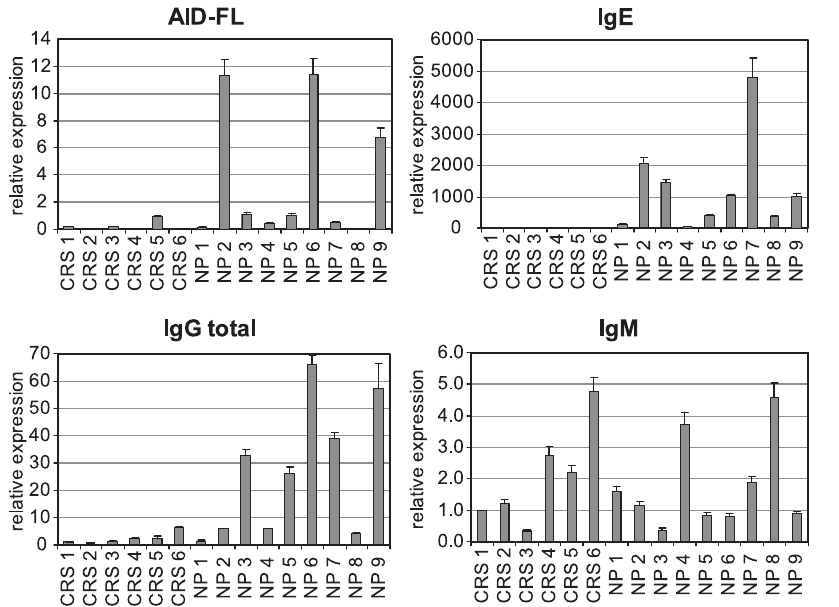
Figure 1. Expression profiles of AID and Ig transcripts in individual samples of patients with chronic rhinosinusitis without (CRS) or with nasal polyps (NP) assayed by real-time PCR. Expression profiles were analyzed using the DD CT method for relative quantification. Expression levels of full-length AID (AID-FL), mature transcripts of IgM, IgG total, and IgE mRNAs were normalized to the average of HKGs and shown relative to CRS1. Results are shown as mean values in one experiment 6 SD and are representative of two independent runs.